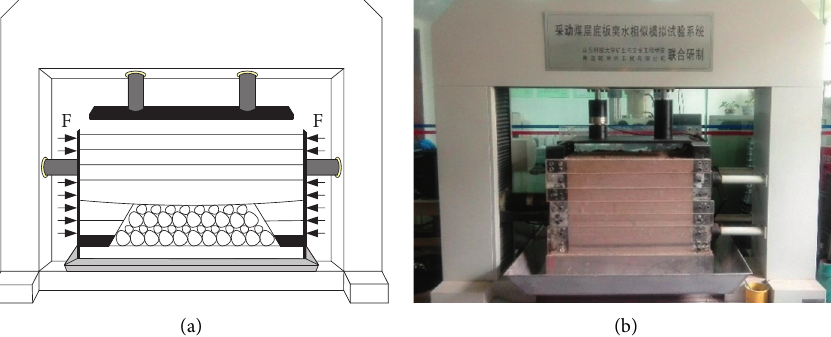
Figure 2: Schematic diagram of the model. (a) Similar simulation test system. (b) Schematic diagram of model stress simulation.